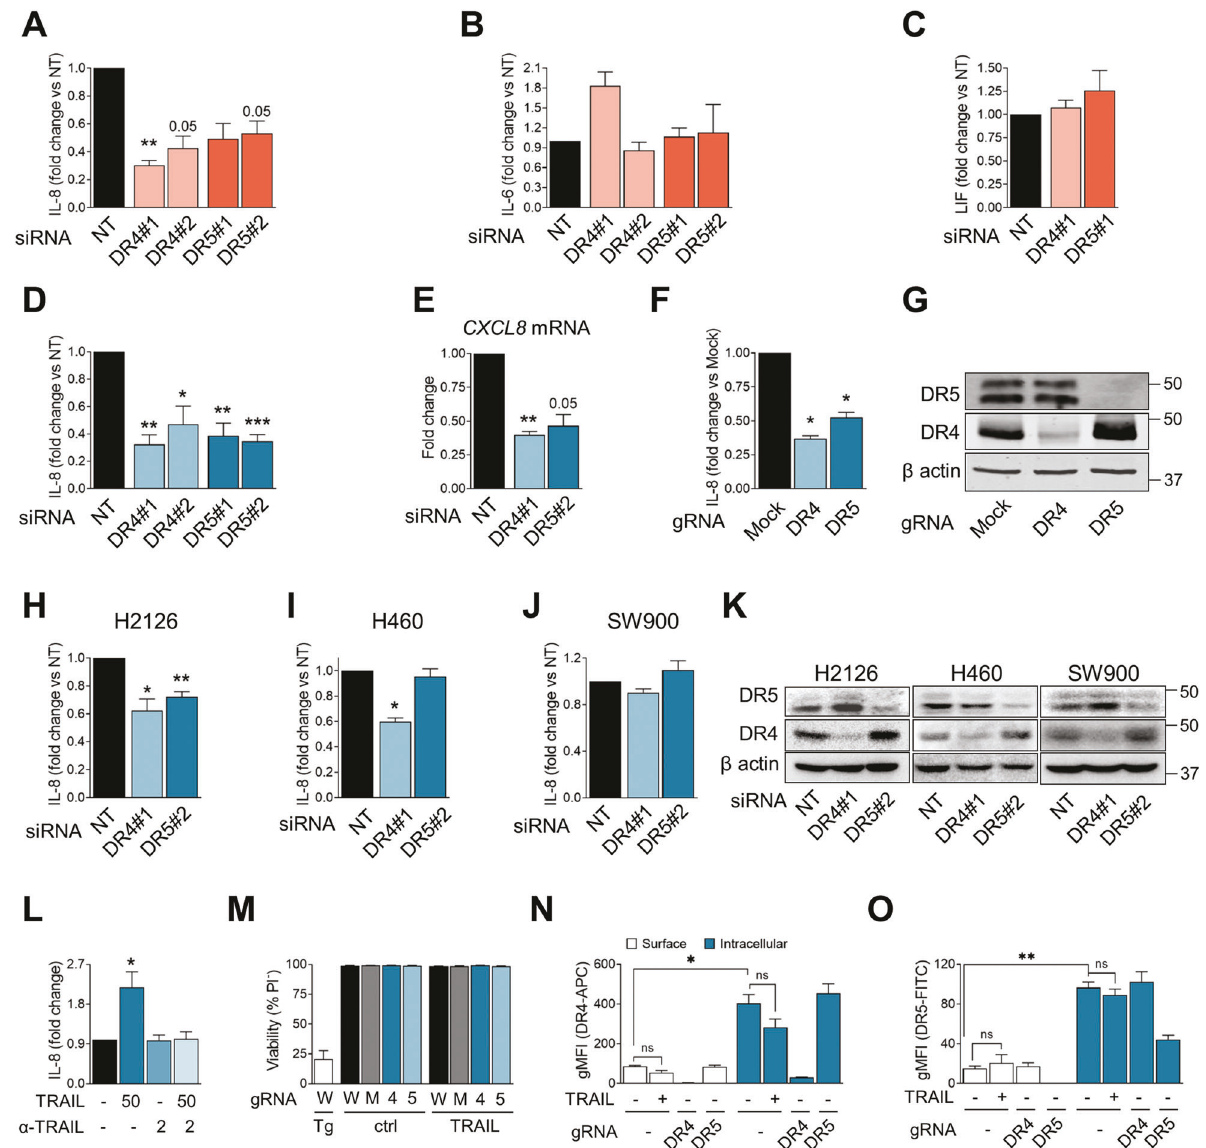
Fig. 4 TRAIL death receptors mediate IL-8 secretion. A – C A549 cells were transfected for 24 h with nontargeting siRNA (labeled as “ NT ” ) or siRNA for DR4 ( “ DR4#1 ” for fi rst sequence and “ DR4#2 ” for second sequence) or siRNA for DR5 ( “ DR5#1 ” for fi rst sequence and “ DR5#2 ” for second sequence). Media was changed for fresh glucose-free media and supernatants were collected 16 h later. IL-8 secretion ( A ), IL-6 ( B ), and LIF ( C ) was measured via ELISA. Results are expressed as Mean of fold change ± SEM ( N = 3). D As in A , but media was changed for fresh rich- glucose media. Mean of fold change ± SEM ( N = 3). E A549 cells were transfected for 24 h with nontargeting siRNA ( “ NT ” ) or siRNA for DR4 ( “ DR4#1 ” ) or siRNA for DR5 ( “ DR5#2 ” ). Media was changed and left it for 16 more hours. Cells were collected 16 h after medium replacement, and IL-8 expression was measured via qPCR, shown as Mean of fold change ± SEM ( N = 3). F , G DR4, DR5 were CRISPRed out in A549 cells. After plating the cells, media was changed and cells were incubated for 24 h. Supernatants were collected and IL-8 secretion was measured ( F ). Results are shown normalized to basal mock. Statistic comparison was made vs their own mock sample. Results are represented as Mean of fold change ± SEM ( N = 4). A representative WB is shown in G . H – K H2126, H460, and SW900 cells were transfected for 24 h with nontargeting siRNA (labeled as “ NT ” ) or siRNA for DR4 (labeled “ DR4#1 ” ) or siRNA for DR5 (labeled “ DR5#2 ” ). Media was changed for fresh one and left it for 24 more hours replaced, and supernatants were collected and 24 h later. IL-8 secretion was measured via ELISA. Results shown as Mean of fold change ± SEM ( N = 3) for H2126 cells ( H ), H460 ( I ), and SW900 ( J ). Representative western blots of DR4 and DR5 upon silencing of DR4 and DR5 are shown in K . L A549 cells were treated with TRAIL (50 ng/ml), antibody anti-TRAIL (2 ng/ml) or their combination for 24 h. Supernatants were collected and IL-8 secretion was measured. Results are expressed as Mean of fold change ± SEM (N at least of 3). M A549 WT (called “ W ” ), Mock (called “ M ” ), DR4 KO (called “ 4 ” ) and DR5 KO (called “ 5 ” ) cells were plated for 24 h and media was replaced with DMEM, DMEM containing 20 µM Thapsigargin as positive control of cell death (Tg) or DMEM containing 50 ng/ml TRAIL. Cells were incubated for 24 h and then collected for PI staining. Cell viability was measured by FACS and indicated as percentage of cells which are PI − . Results are expressed as Mean ± SEM ( N = 3). N A549 WT, DR4 KO and DR5 KO cells were plated for 24 h. Media was changed to fresh DMEM or fresh DMEM with TRAIL (50 ng/ml) as indicated for an additional 24 h. Cells were collected and stained for surface or total DR4. Cells were measured by FACS and intracellular staining was calculated by subtracting the gMFI of the surface staining to the gMFI of the total staining. Results are shown as gMFI ± SEM ( N = 3). O Same as N but for DR5. Statistical analysis performed using Ratio paired t -test compared to NT, or to Mock basal level for F . p -value: * p < 0.05, ** p < 0.01, *** p < 0.001.